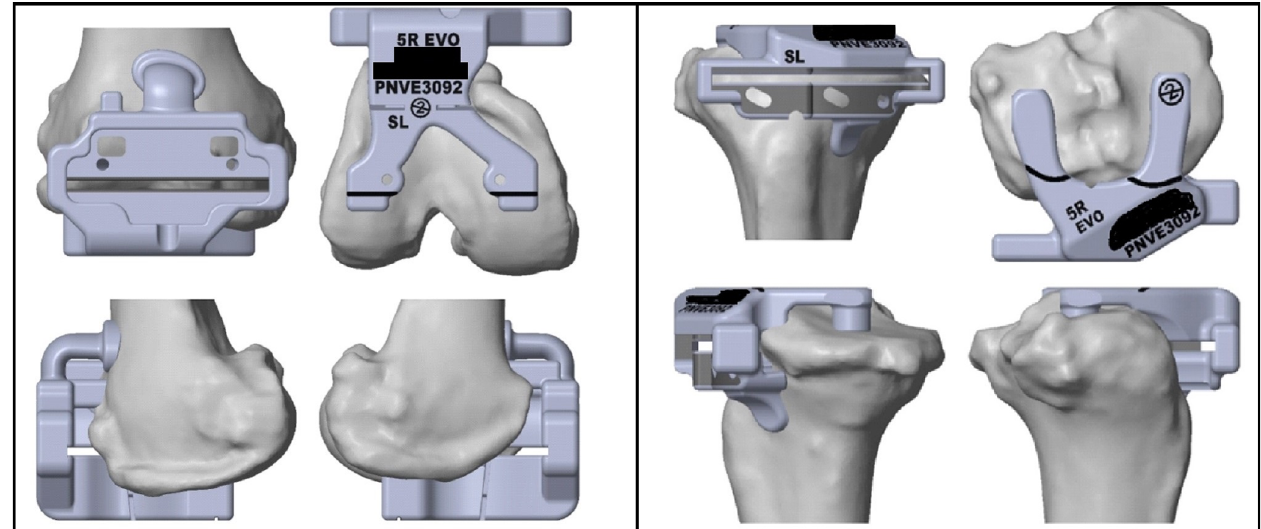
Figure 1. Femoral and tibial cutting block mounted on the distal femur and on the proximal tibia respectively. These are company manufactured patient speci fi c femoral cutting blocks based on CT scan created virtual bone models. Multiple contact points on the femoral cutting block and the tibial cutting block, along with markings allow accurate positioning and rotational alignment improving accuracy of the cuts and femoral and tibial rotation respectively. There are slots for external jigs to double check slope and tibial base plate